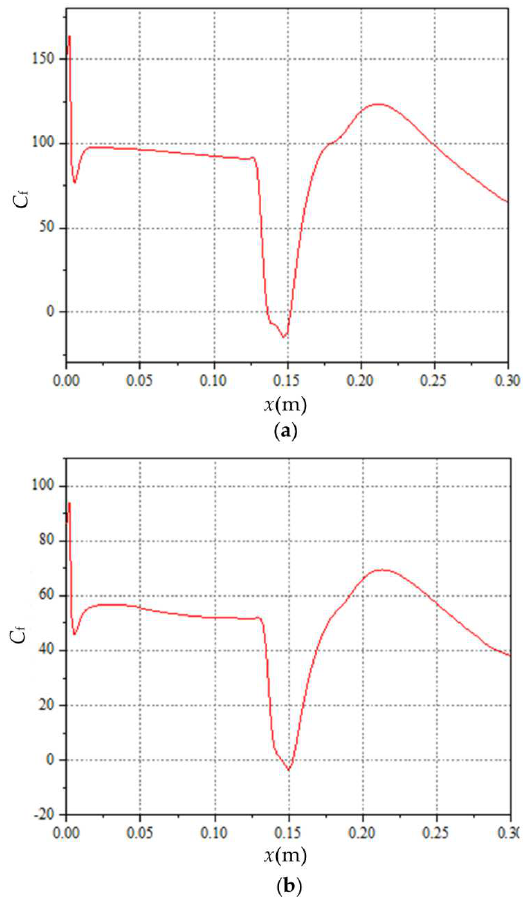
Figure 13. Skin friction coefficient curve of base flow field at different spanwise cross sections: ( a ) z = 0.025 m; ( b ) z = 0.054